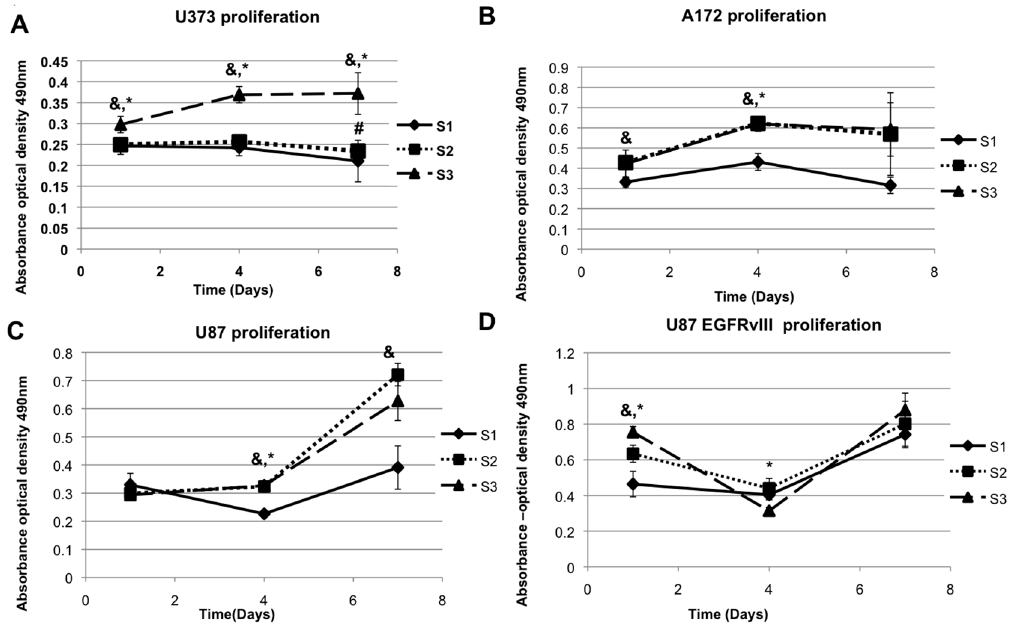
Figure 2. Cell proliferation rates as an effect of elastic moduli. U373 cells ( A ), A172 cells ( B ), U87 ( C ), and U87 EGFRvIII cells ( D ). * denotes p value is less than 0.05 when S1 and S3 values were compared. & denotes p value is less than 0.05 when values of S2 and S3 were compared and # denotes when p value is less than 0.05 when S1 and S2 values where compared.